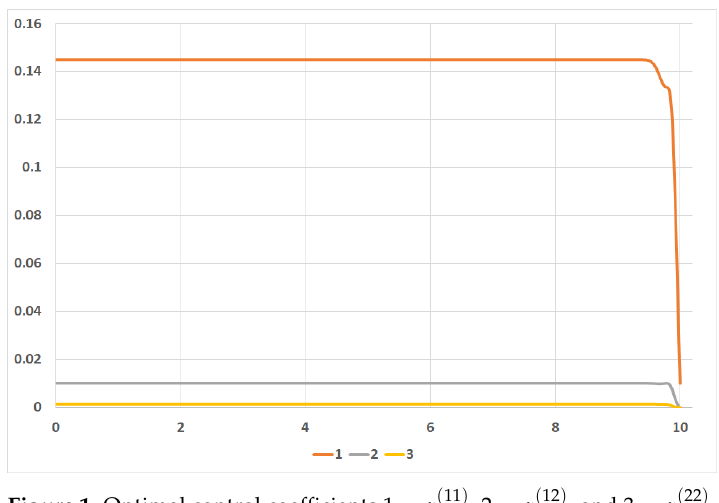
Figure 1. Optimal control coefficients 1 − α